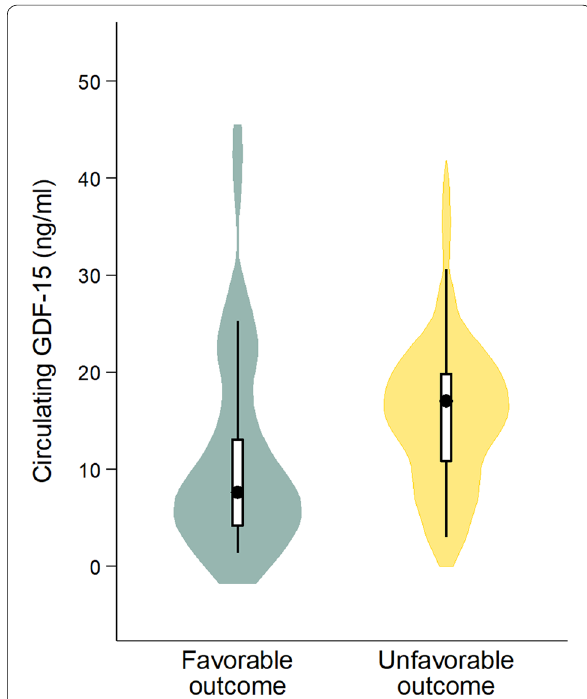
Fig. 1 Violin plot showing the distribution of GDF‑15 values in patients with and patients without adverse neurological outcome